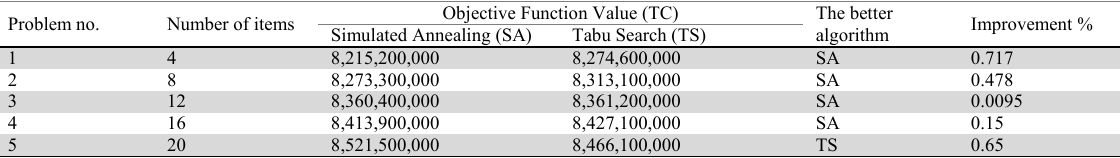
The Fuzzy total VMI cost obtained by the algorithms Problem no. Number of items